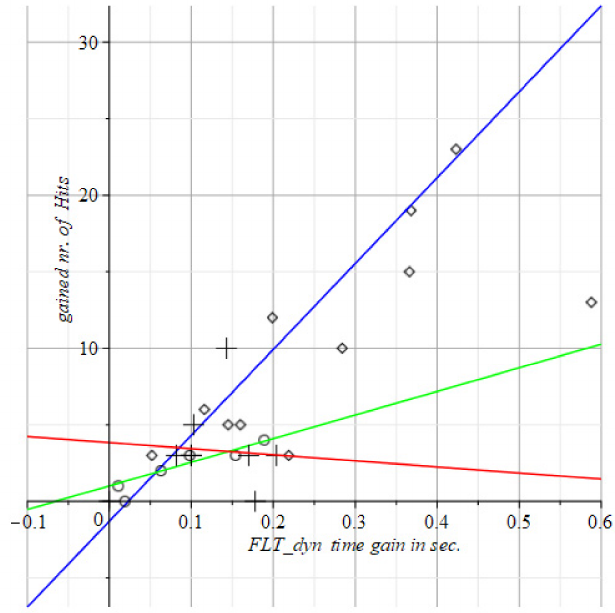
Figure 9. Depicts the results of the dynamic FitLight ® s test. This test requires rapid eye movements, hence the results of the blue line are best. Circles and green line: Motor group, T 1 = 1.80 ( ± 1.60) + 17.2 ( ± 0.14) T 0 . Rhombus pts., blue: Visuo-spatial-motor group, T 1 = 0.52 ( ± 2.17) + 39.2 ( ± 0.24) T 0 . Plus signs, red line: Control group, T 1 = 0.51 ( ± 0.94) + 34.7 ( ± 0.12) T 0 .